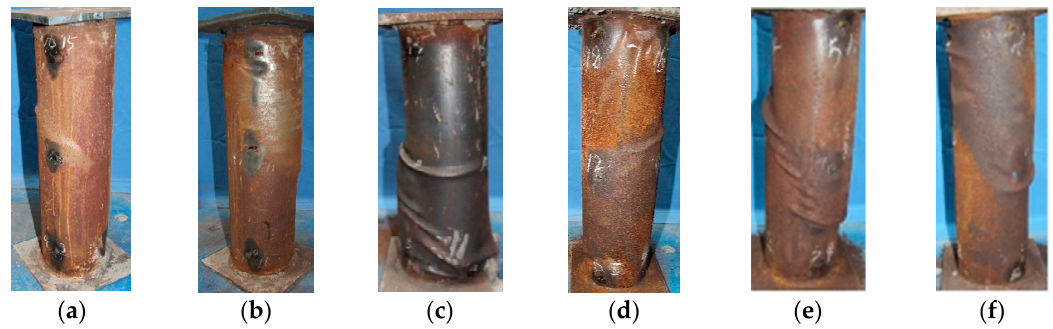
Figure 5. Photographs of CFST columns after failure. ( a ) CSC1-1; ( b ) CSC2-1; ( c ) CSC3-1; ( d ) CSC1-3; ( e ) CSC2-4; ( f ) CSC3-2.